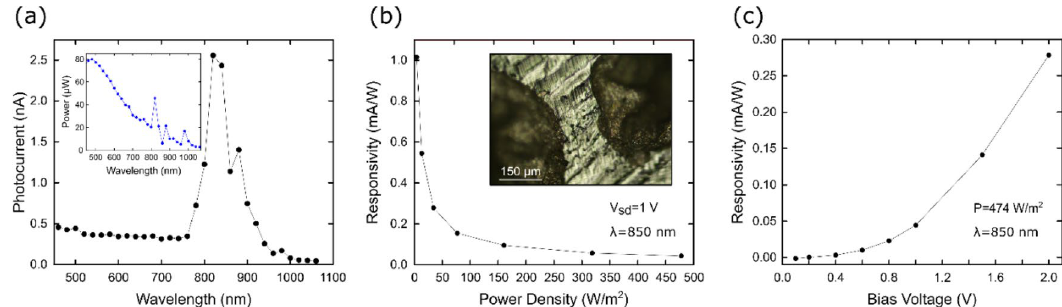
Figure 7. ( a ) Photocurrent of the device as a function of the light wavelength (bias voltage of 1 V). The inset displays the light power of the tunable light source as a function of the wavelength. ( b ) Responsivity as a function of the power density with a LED illumination source. The inset shows the measured pellet and the two silver paint drops that were used as electrodes. ( c ) Responsivity as a function of the bias voltage. A LED illumination source was employed to illuminate the